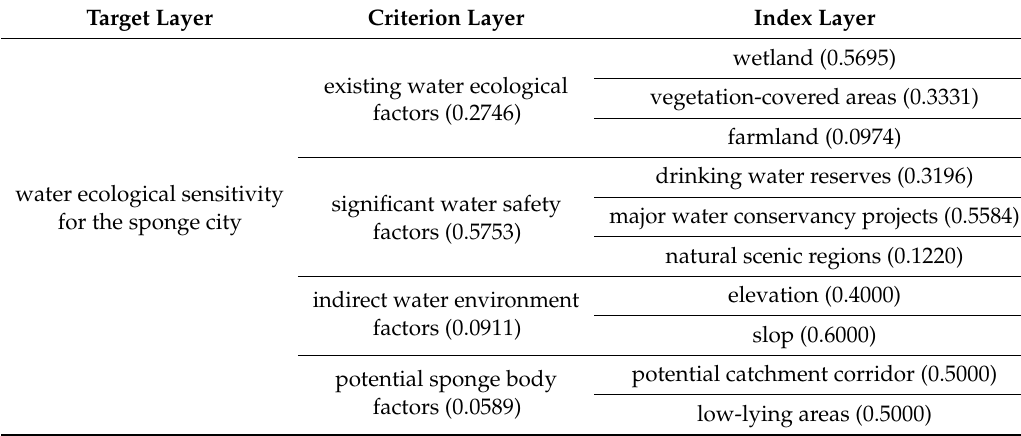
Table 1. Comprehensive evaluation index system of water ecological sensitivity for the sponge